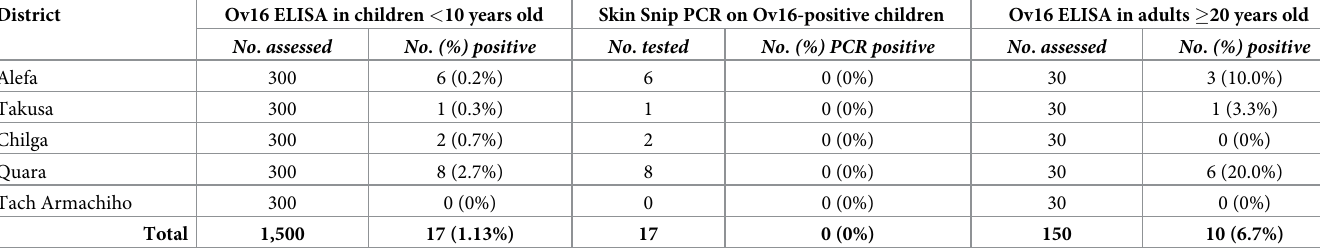
Table 4. 2016 Ov16 ELISA from districts in and around the buffer zone bordering the Metema sub focus. District Ov16 ELISA in children < 10 years old Skin Snip PCR on Ov16-positive children Ov16 ELISA in adults � 20 years old No . assessed No . tested No .